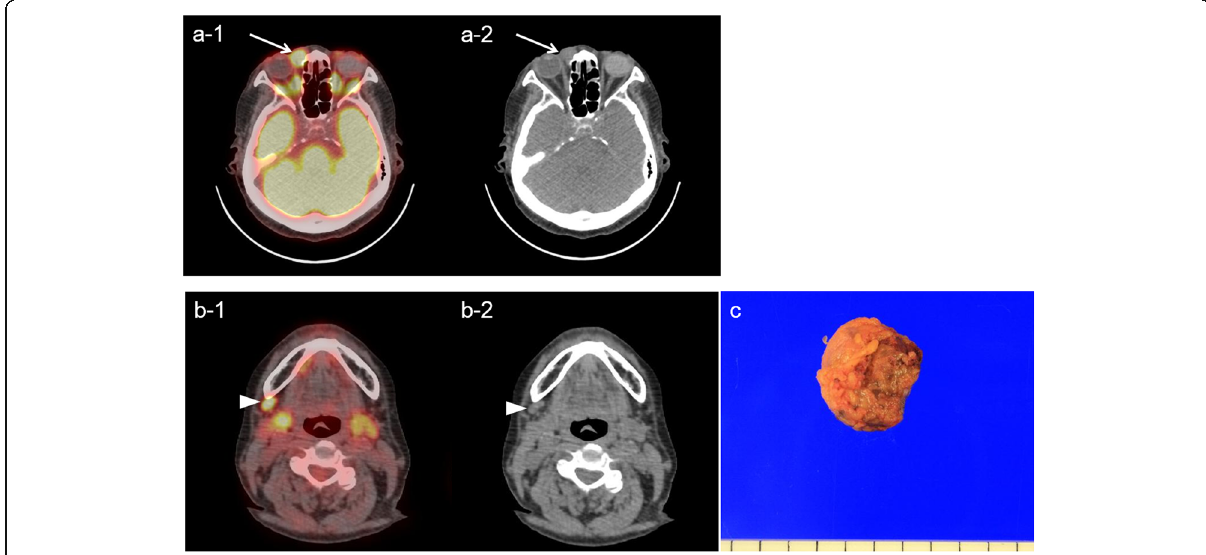
Fig. 3 OAML in right orbit (lacrimal sac) with cervical LN involvement. A 72-year-old female had MALT lymphoma in right orbit. a Focal FDG uptake was seen in right lacrimal sac (arrows, SUVmax 10.5) on FDG PET/CT scan. b Another focal FDG uptake was noted in right cervical level I (arrowheads, SUVmax 10.8). c Surgical excision of right cervical level I LN was done, and the final pathology was MALT